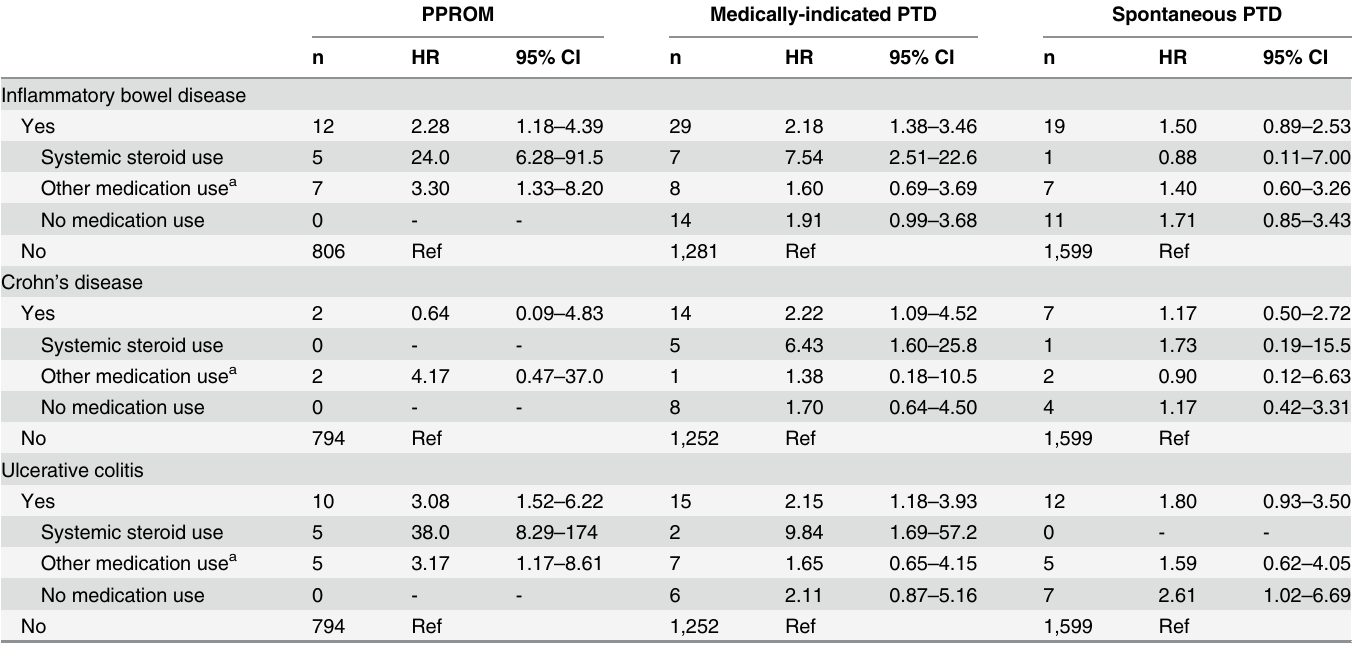
Table 3. Associations between inflammatory bowel disease, medication use during pregnancy and rates of preterm delivery (PTD) subtypes in the Danish National Birth Cohort, 1996 –